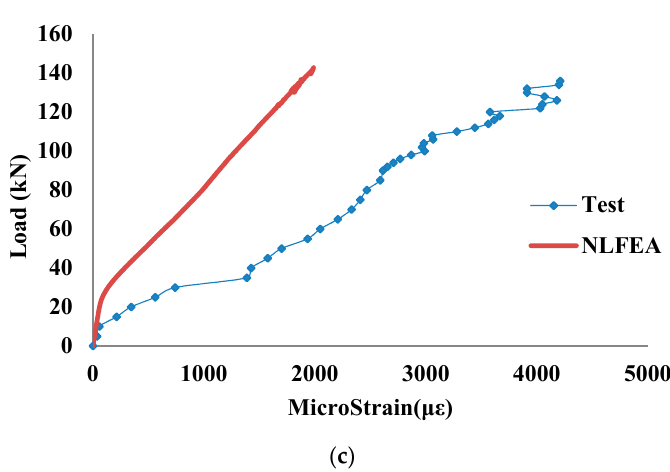
Figure 19. Comparison of load vs. strain in longitudinal reinforcement: ( a ) Test model coded as S-Con; ( b ) Test model coded as S-C-2-9; ( c ) Test model coded as S-C-2-1.